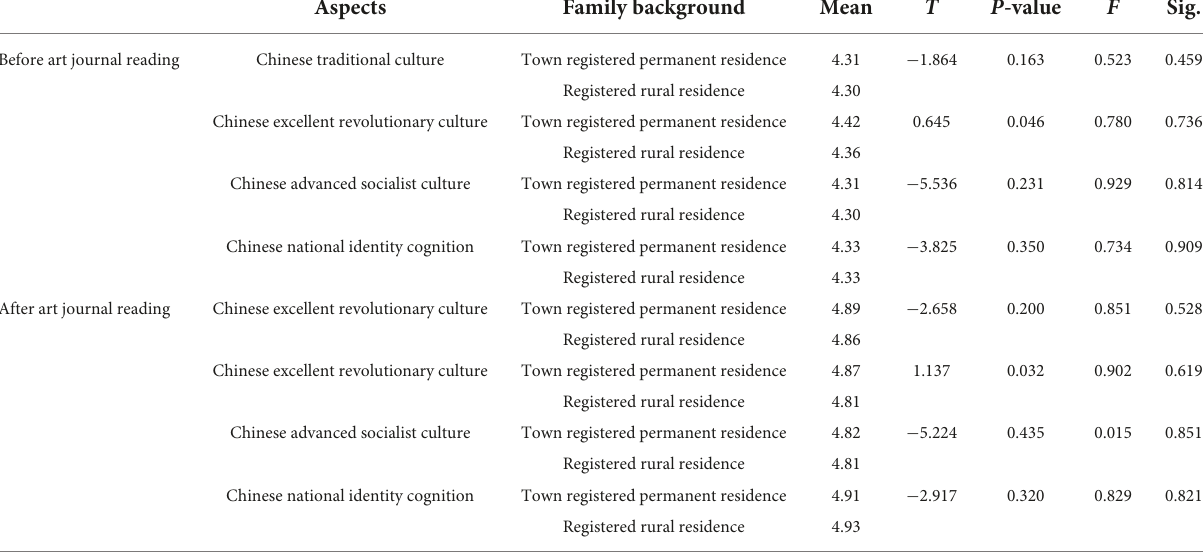
TABLE 6 Comparison of the national cognition and cultural acceptance of college students from different family